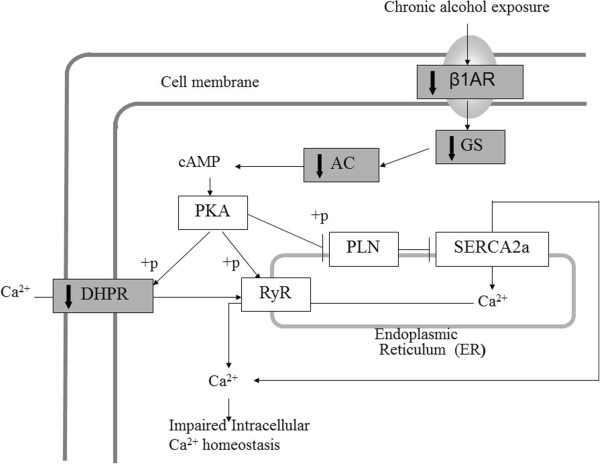
Hypothesis of adolescent chronic alcohol consumption effect on SPIF gene down regulation in the dilated cardiomyopathy signaling pathway. Diagram was adapted from KEGG pathway (http://www.genome.jp/kegg/) [92] for dilated cardiomyopathy (DCM), showing the β1AR-DHPR-Ca2+ branch of the DCM pathway. Adolescent chronic alcohol consumption is hypothesized to result in the down regulation of SPIF genes (marked with grey color and solid down arrows), including β1-adrenergic receptor (Adrb1), Gs protein (Gnas), adenylyl cyclase 1 (Adcy1), and dihydropyridine receptor/L-type calcium channel (Cacna1d). The coordinated down regulation of these SPIF genes leads to impaired intracellular Ca2+ homeostasis at the cellular level.